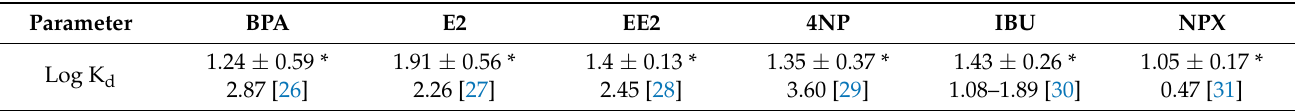
Table 6. Distribution of the Log K d obtained for the drugs and CDEs detected and that determined in other studies.